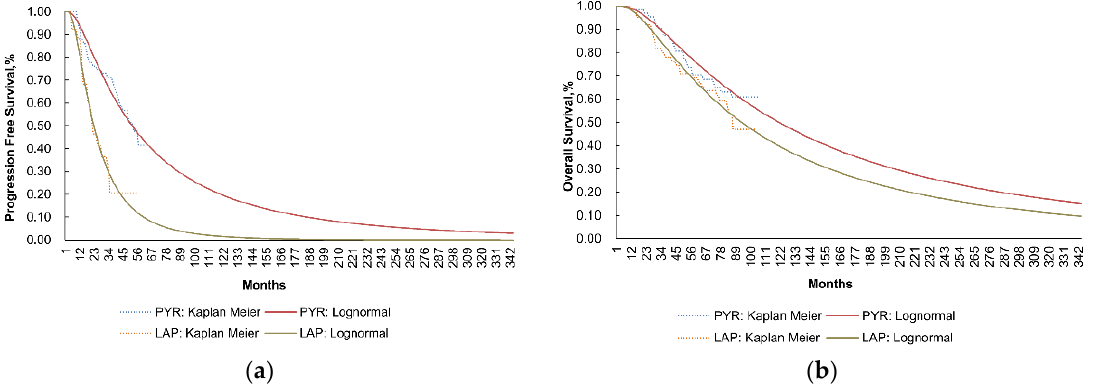
Figure 2. Kaplan – Meier Curve and Lognormal-estimated progression-free survival ( a ) and overall survival ( b ) with pyrotinib plus capecitabine and lapatinib plus capecitabine. Abbreviations: PYR, pyrotinib; LAP, lapatinib.